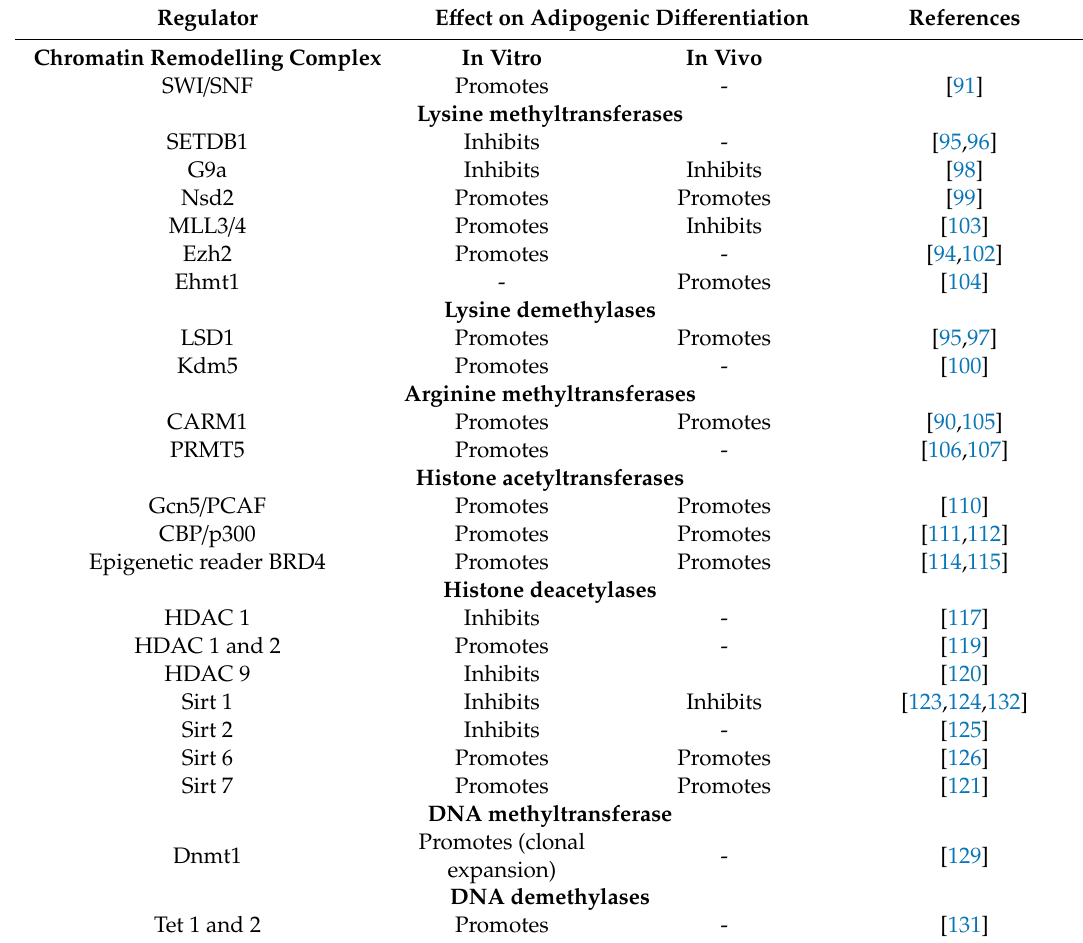
Table 2. Epigenetic factors involved in the regulation of